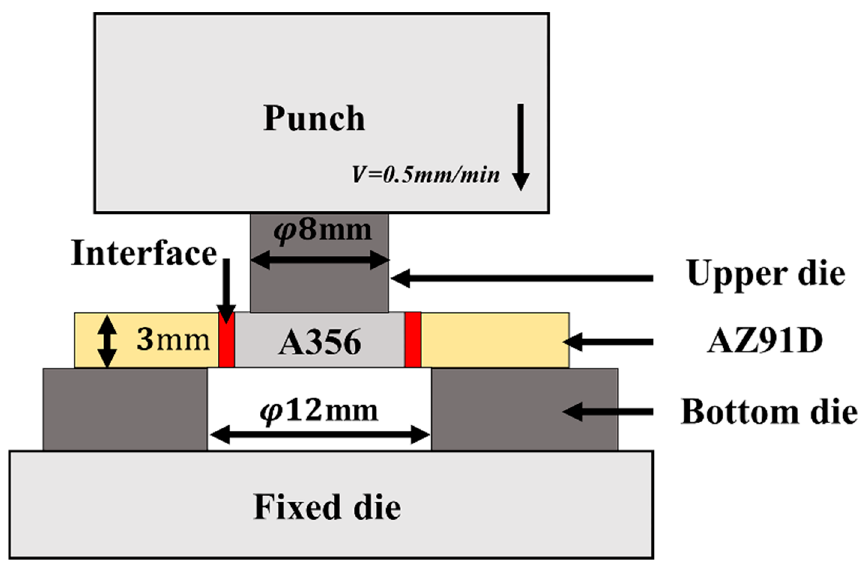
Figure 3. Schematic diagram of the push-out test for the shear strength testing.